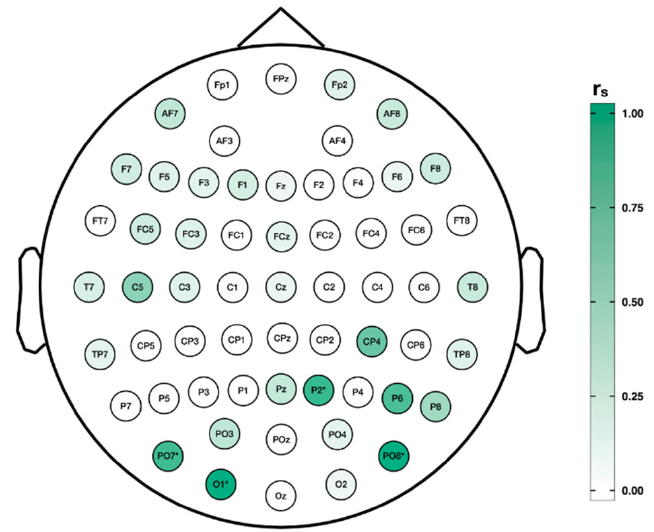
Figure 3. Reliability of TMS-induced changes in oscillatory brain activity. Spearman correlations coefficients (r s ) of right hemispheric 1 Hz rTMS-induced changes in the gamma frequency band (33–44 Hz) for the two test session days are projected on a topographical map per electrode in Figure 3. Significant reliable electrodes are highlighted with asterisks. Separate reliable changes are primarily present over parieto-occipital electrodes, whereby neighboring channels PO7 and O1 form a significant reliable cluster. However, this effect disappears after a correction for multiple comparisons and is therefore only conditionally